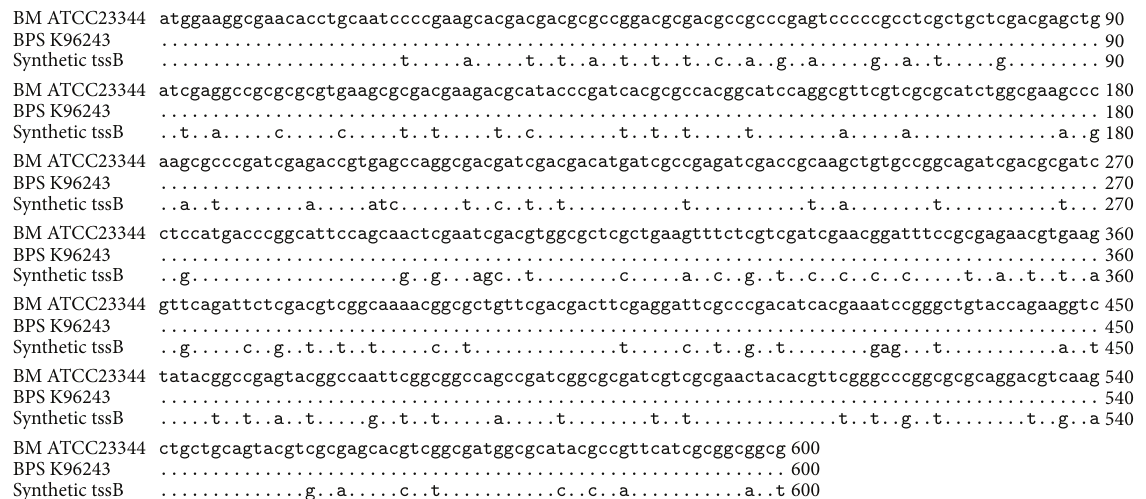
at 492 nm in a microtiter plate reader (Titertek Multiskan, Finland).